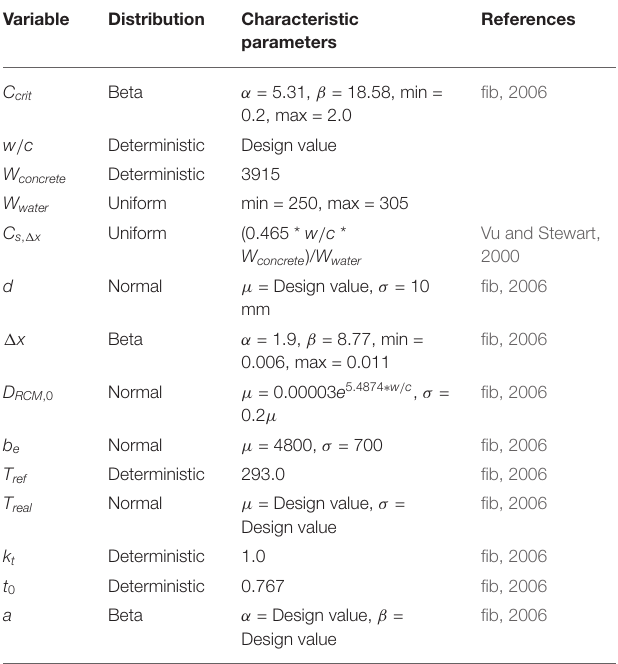
TABLE 1 | Service life modeling variables, distributions, and characteristic parameters.